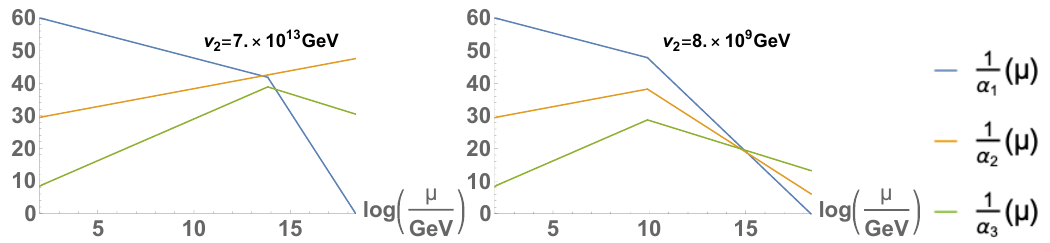
Figure 4 . Running coupling constants of the SM. Left panel: (cid:12)rst model discussed in section 3.6, right panel: second